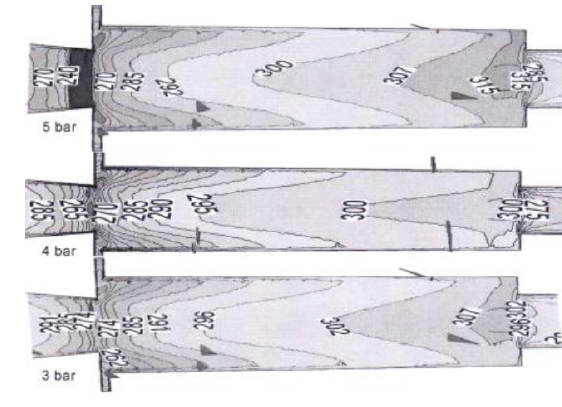
Figure 19. Plots of static temperature at different location of hot end using RNG k-epsilon at 5 bar.